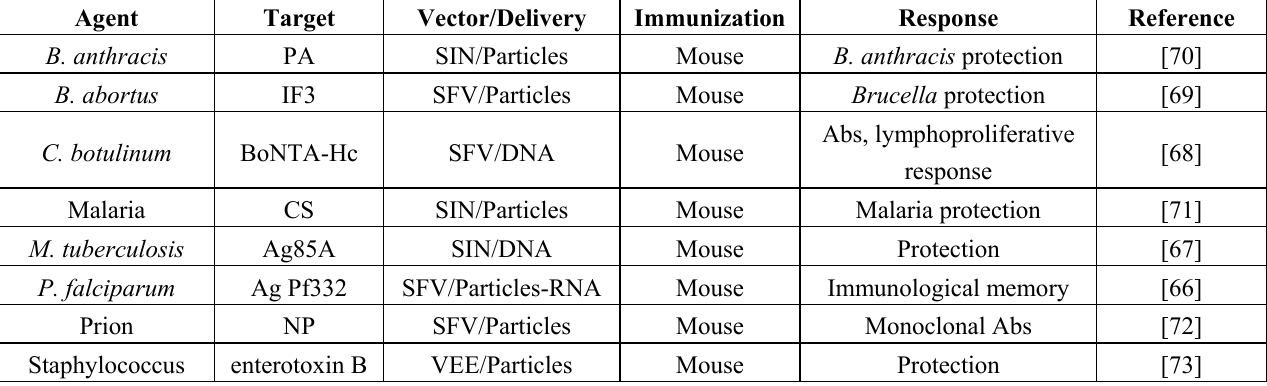
Table 2. Alphavirus-based vaccine development for non-viral infectious